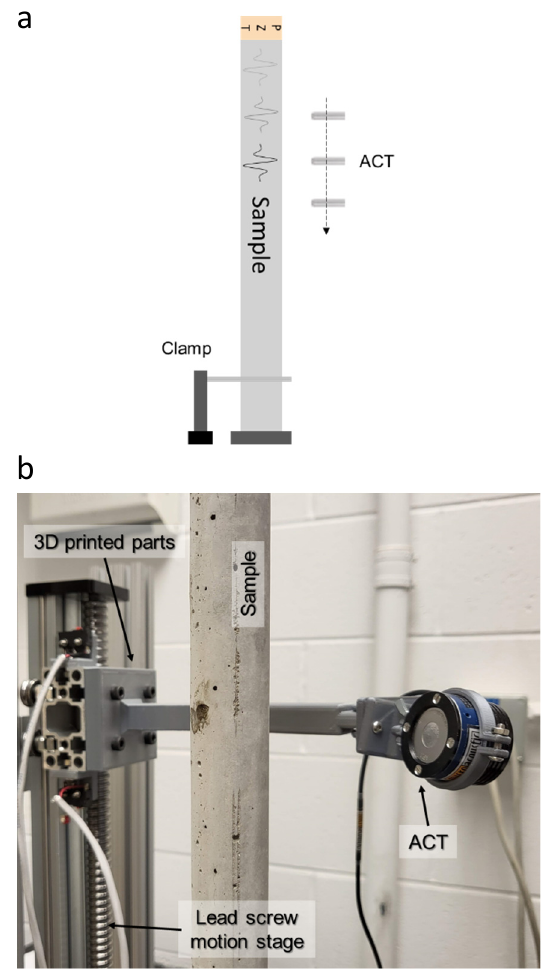
Figure 3. The mechanical wave measurement system: (a) a schematic image that shows the entire measurement system and (b) detailed view of the measurement system with the mortar